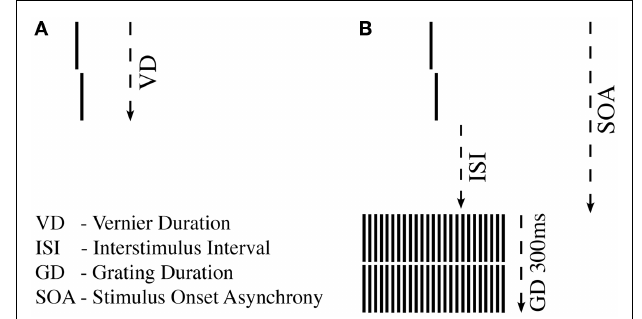
FIGURE 1 | Shine-through paradigm . (A) A vernier comprised two vertical bars which were slightly offset to the left (not shown) or right (shown here). Observers indicated this offset direction. For each observer, we determined the individual vernier duration (VD) for which 75% correct responses were reached. (B) In the next step, this individual vernier duration was used for each observer.The vernier offset was fixed at 71 (cid:48)(cid:48) (arc sec).This vernier was followed by a blank screen (ISI) and a grating comprised of 25 aligned verniers, i.e., verniers without offset. SOA = VD + ISI.